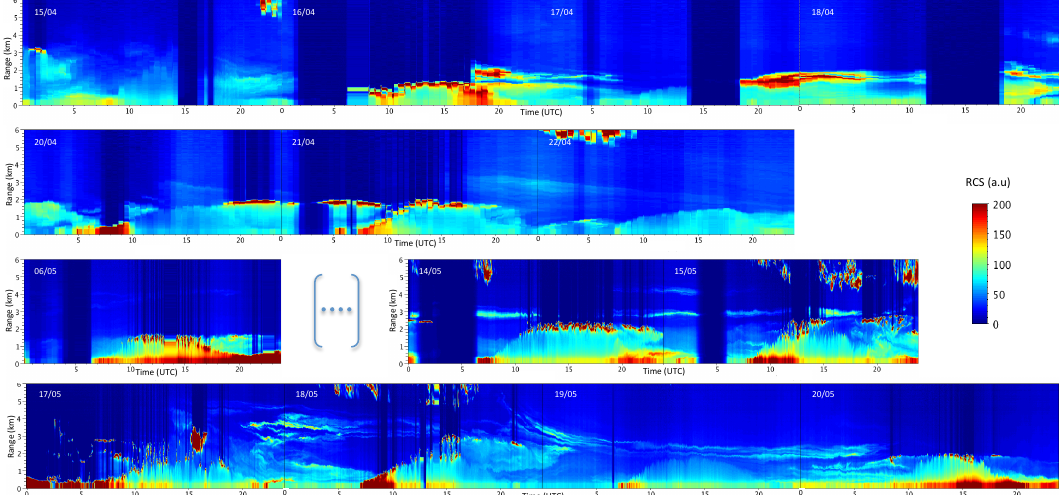
Fig. 5. Time series of lidar range corrected power P(z) at 532nm (maximum altitude considered is 6km). Blue brackets separate the two observing periods (from 15 April to 20 May